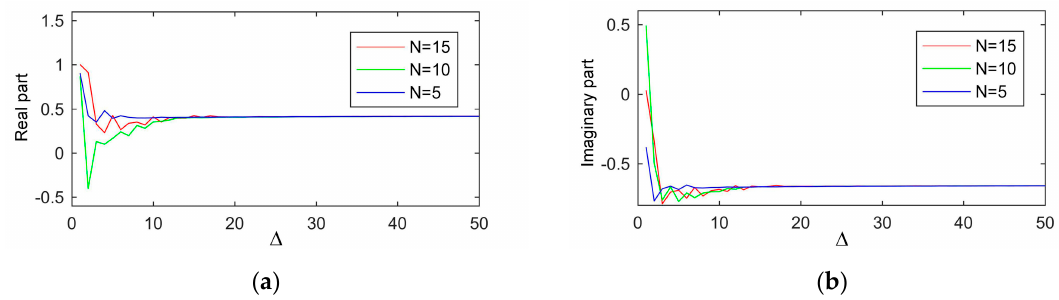
Figure 5. The influence of N and M on the reflection coefficient: (a), real part; (b), imaginary part.